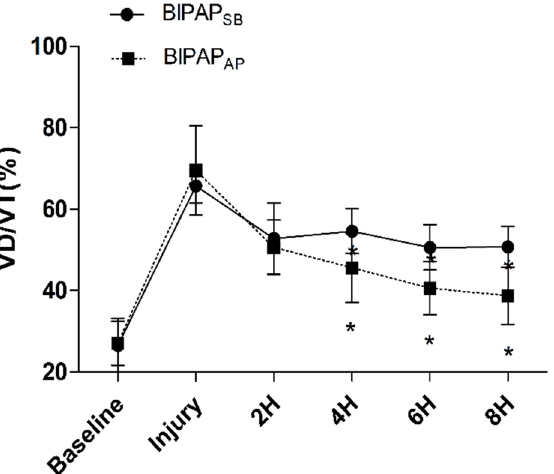
Fig 2. Time course of the VD/VT. Time course of the dead space volume to tidal volume (VD/VT) ratio in experimental groups (n = 6 per group). BIPAP SB = biphasic positive airway pressure with SB; BIPAP AP = biphasic positive airway pressure with abdominal muscles paralysis; SB = spontaneous breathing; * P < 0.05, vs. other groups.